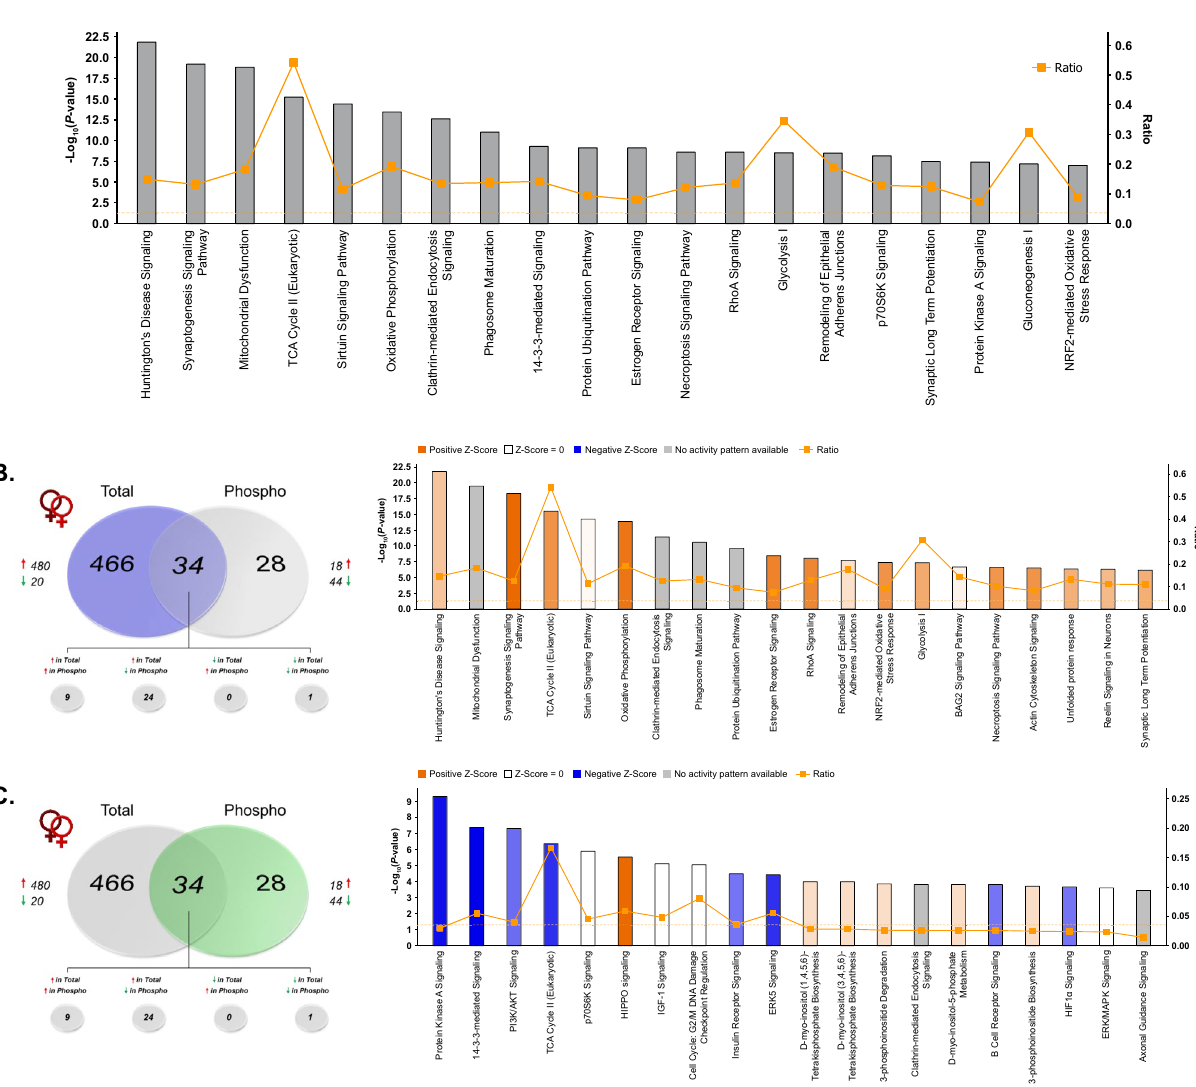
Figure 5. IPA enrichment analyses of proteins and phosphoproteins differentially abundant between proestrus and diestrus female rats. ( A ) Canonical pathway enrichment for combined list of proteins and phosphoproteins significantly differentially abundant between proestrus and diestrus female rats. Separate IPA analyses of total ( B ) and phosphoproteins ( C ) with estrous cycle-dependent abundance describe contributions of each fraction to predicted activity levels within enriched pathways. Based upon the direction of fold change of significant differentially abundant proteins/phosphoproteins within the dataset, the Z -Score serves as a predictor of pathway activation states by assessing the match between the observed and predicted (evidence-based) up/ down regulation patterns 41 . Pathways are colored by predicted activation state: orange (activated) or blue (inhibited), where darker colors represent higher absolute Z -scores. Z-scores for pathways colored in gray could not be calculated due to insufficient evidence for a prediction of either activation or inhibition to be made. The ratio (solid orange line) represents the number of molecules within the comparison dataset meeting the cutoff criterion ( p < 0.05; Fisher’s Exact Test), divided by the number of molecules comprising a given pathway within the reference set (Ingenuity Knowledge Base). Bar graphs were produced in Ingenuity Pathway Analysis (IPA) software (QIAGEN,